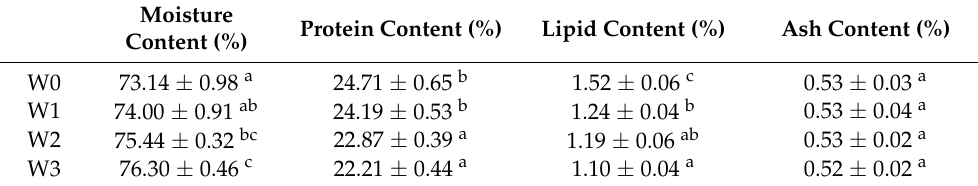
Table 1. Basic composition of surimi with different washing times.